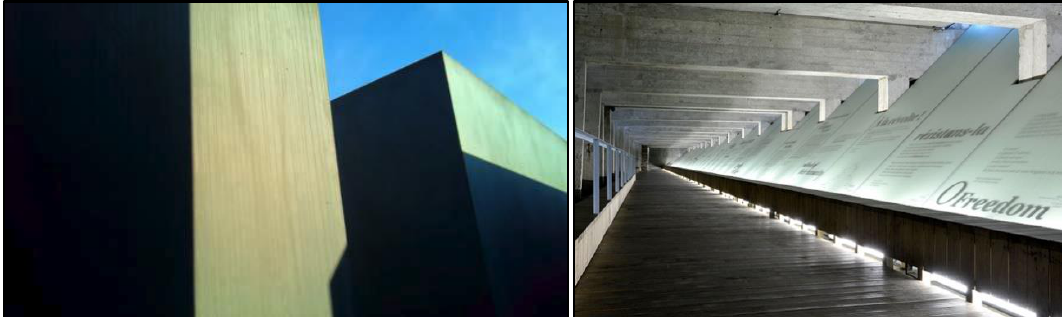
Figure 4. MMJE from the participant’s (subcam) ( left ) perspective and Memorial to the Abolition of Slavery (Nantes) ( right ).